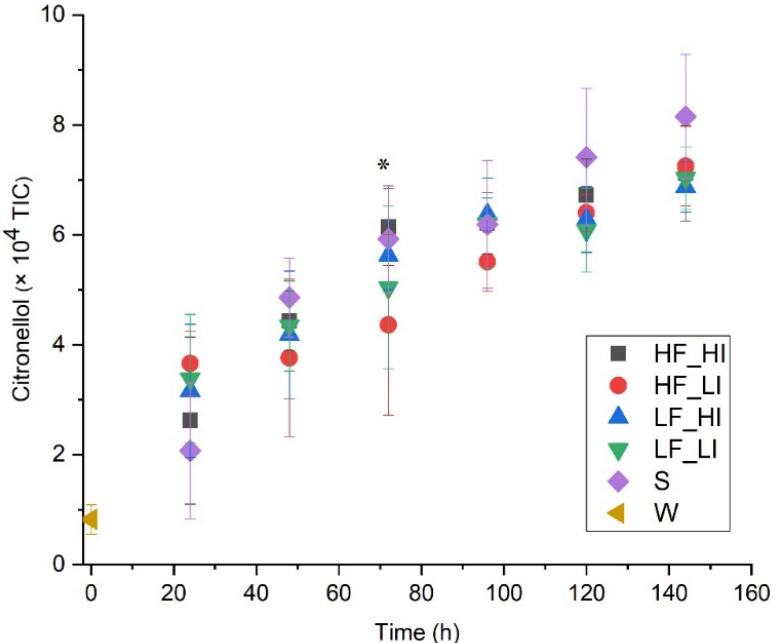
Figure 6. Abundance of Citronellol (A25) during fermentation for five sound treatments including a silent control. Low-frequency and low-intensity (LF_LI); low-frequency and high-intensity (LF_HI); high-frequency and low-intensity (HF_LI); high-frequency and high-intensity (HF_HI); silence (S); wort (W). The results shown are means ± standard deviations of 6 measurements (3 biological fermentation replicates × 2 analytical replicates). * Significant difference observed among treatments (see Table A1).